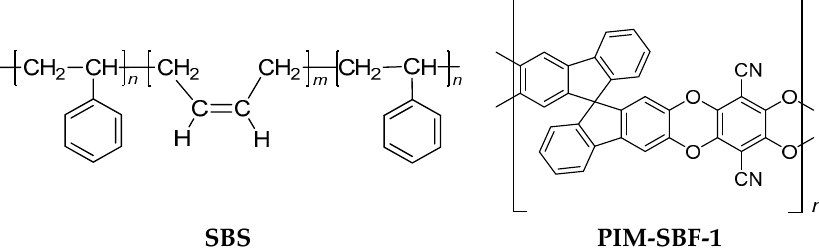
Figure 1. Structural formulas of Styrene-Butadiene-Styrene triblock copolymer (SBS) and the polymer of intrinsic microporosity, PIM-SBF-1 [36,37].